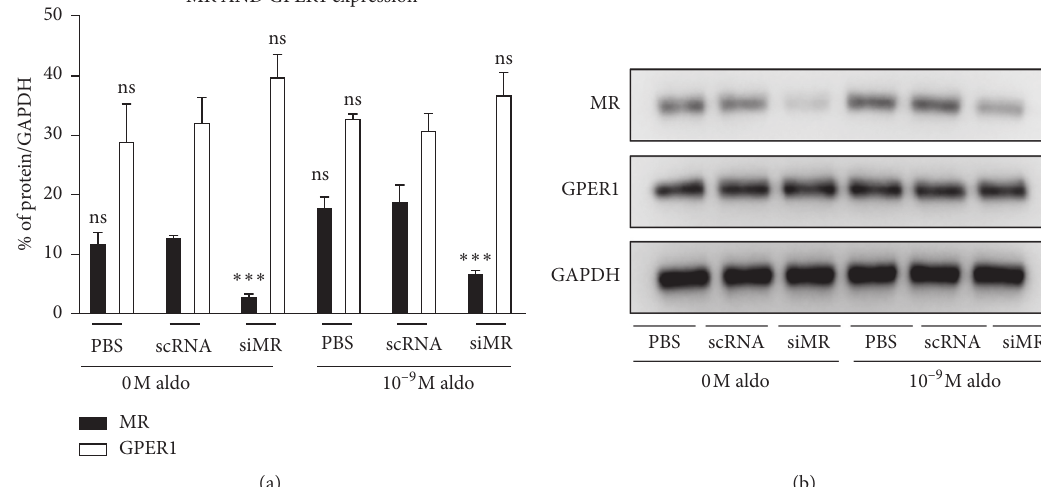
Figure 2: MR and GPER1 protein level before and after MR knockdown with or without aldosterone: (a) protein level of MR and GPER1; (b) Western blot of MR and GPER1. scRNA: the state with control RNA, siMR: the state after MR knockdown, aldo: aldosterone. ∗∗∗ p value < 0.001 compared with scRNA under the same aldosterone concentration. ns: nonsignificant compared with scRNA under the same concentration.